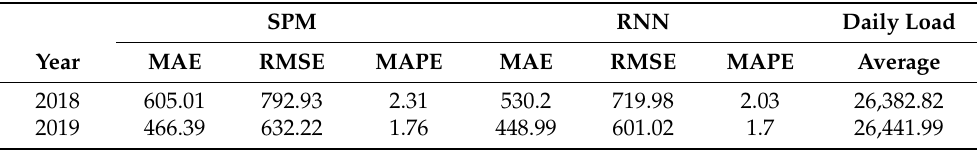
Table 2. Comparisons of the Model Performances of the next ( D +1)-day Forecasting Accuracies of the SPM and RNN Models with Historical Temperatures.